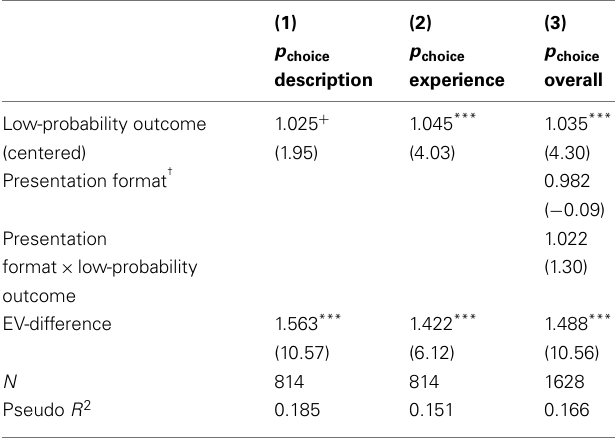
Table 1 | Logistic regression of choices for the gamble comprising the rare event ( p choice